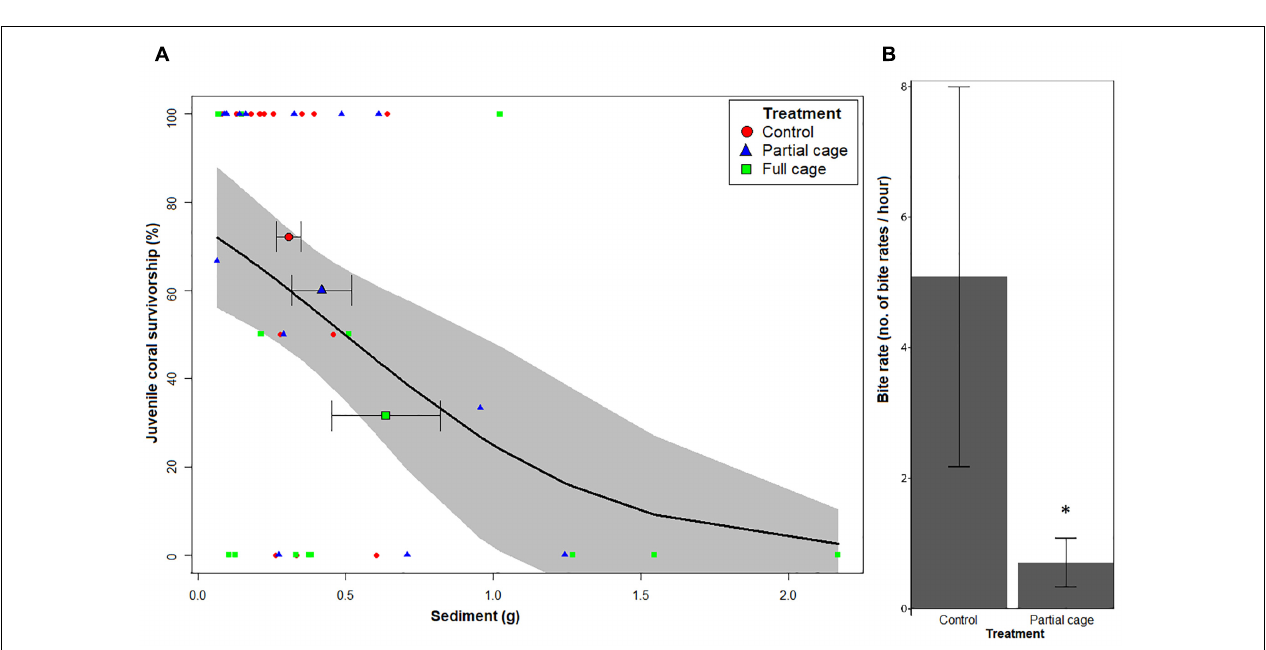
FIGURE 3 | Proportion of live coral juveniles across caging treatments during the experimental period. Points and error bars correspond to mean proportion and standard errors ( ± SE), respectively, at each monitoring period.